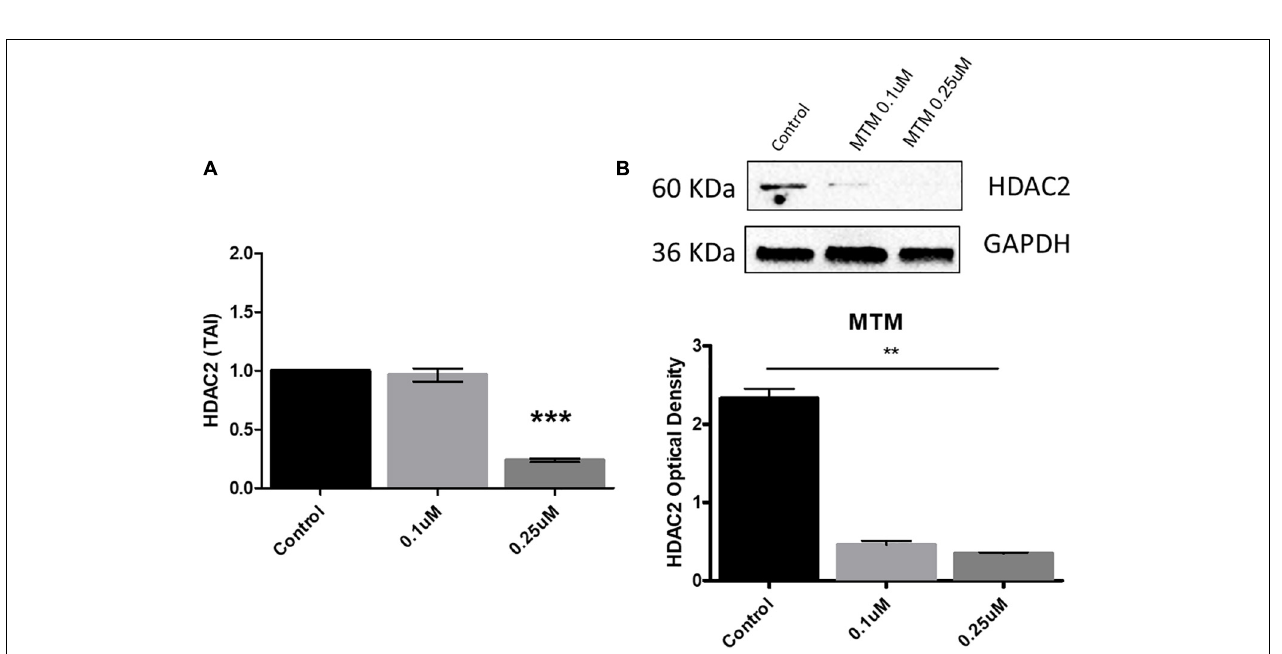
FIGURE 4 | Mithramycin A (MTM) inhibits histone deacetylase 2 (HDAC2) expression. Amyloid overexpressing cells (SH-APP) were exposed to different concentrations of MTM and found that at 0.25 µ M concentration significantly inhibits both HDAC2 gene (A) and protein (B) expression ( ∗∗ p ≤ 0.01; ∗∗∗ p ≤ 0.001).